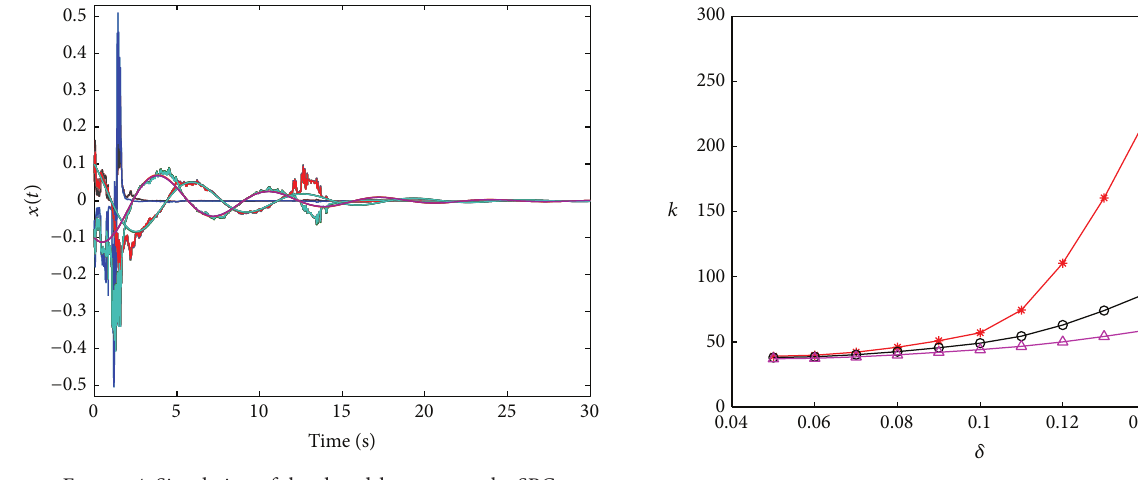
Figure 4: Simulation of the closed-loop system by SPC.